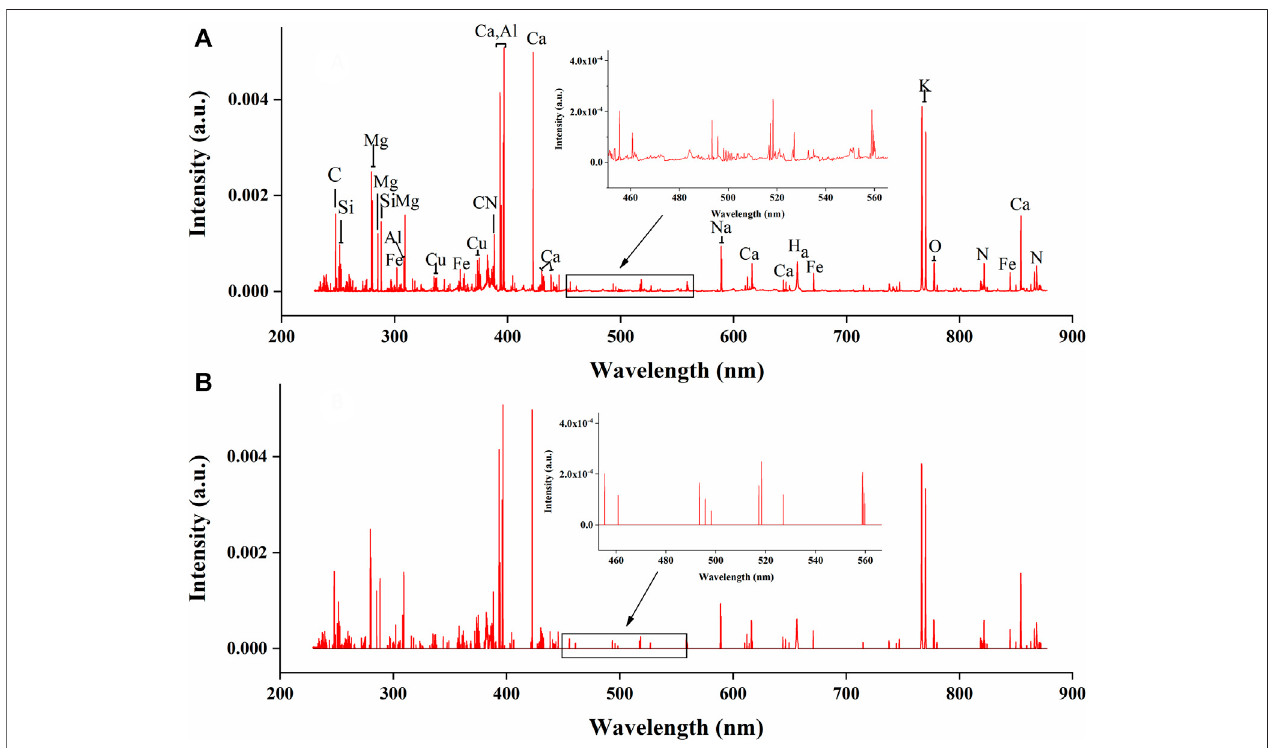
FIGURE 5 | The average LIBS spectra for underground parts of G. rigescens Franch with (A) original variables and (B) reserved variables by standard deviation. Note: The variables with near-zero standard deviation were set as “ 0 ” and colored black for better comparison.